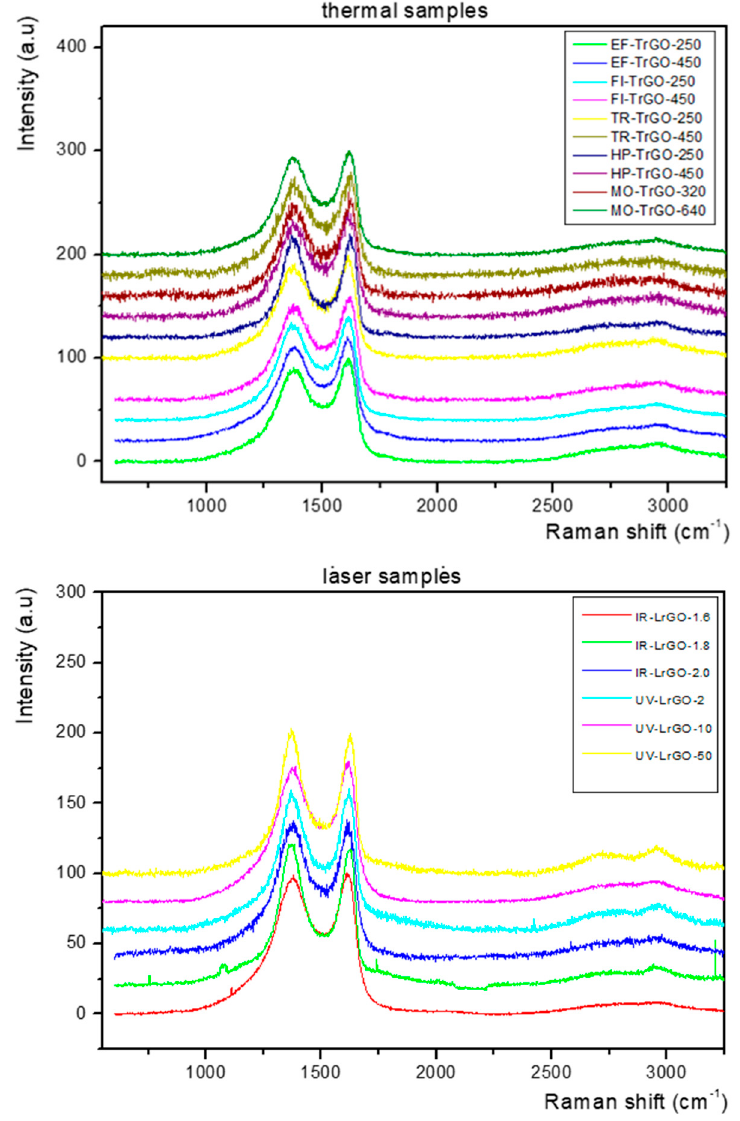
Figure 5. Raman spectra corresponding to the TrGO ( top ) and LrGO ( bottom ) samples. All spectra were normalized to the intensity of the G band.